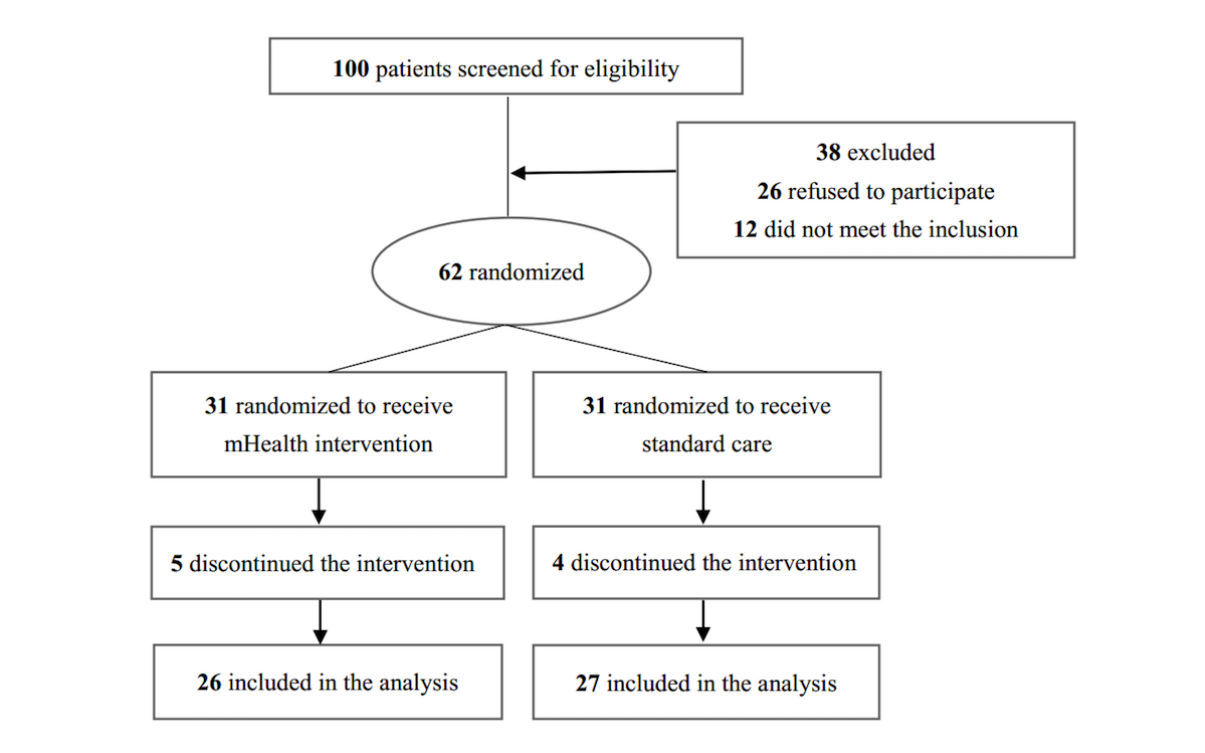
Figure 1. Flowchart of the pilot